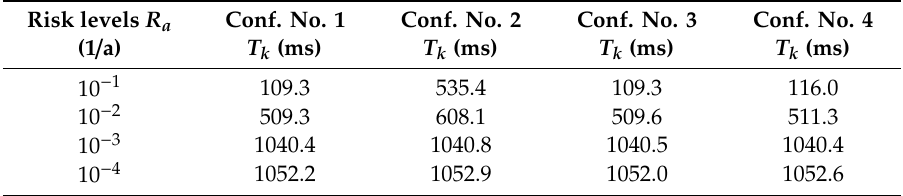
Table 2. Short circuit duration values T k found at lookout point A for selected risk levels R a and four PSPA configurations.